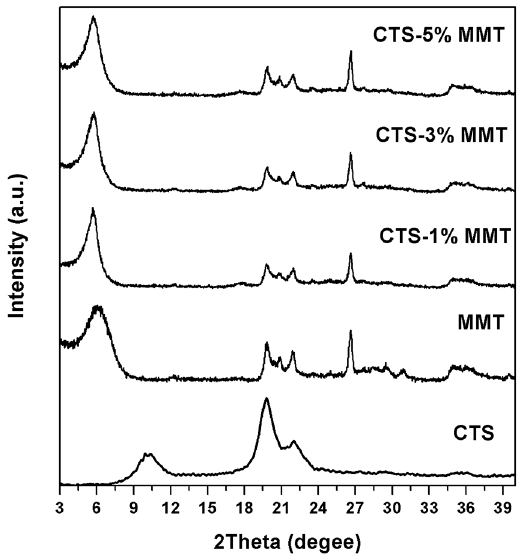
Figure 1: XRD patterns of CTS, MMT, and CTS-MMT composite beads.